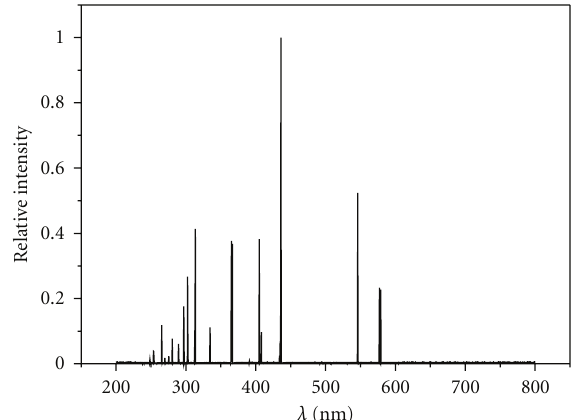
Figure 2: Irradiance spectra of the high-pressure mercury lamp light